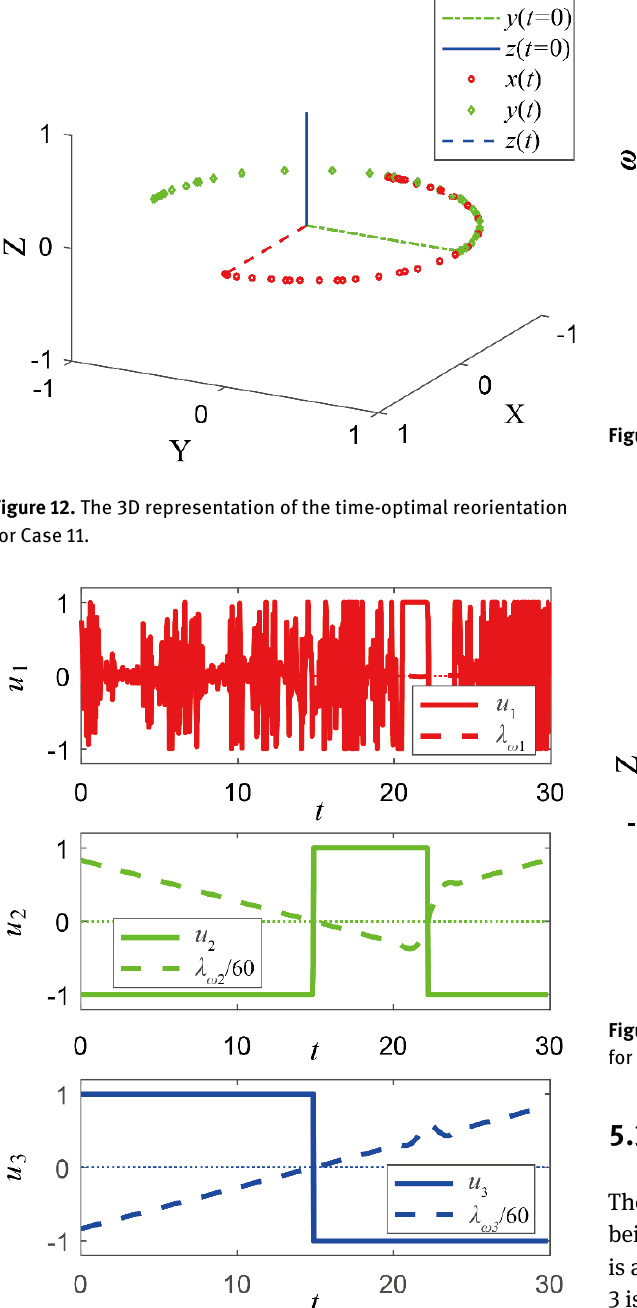
Figure 13. The optimal control histories and switching functions for Case 17.